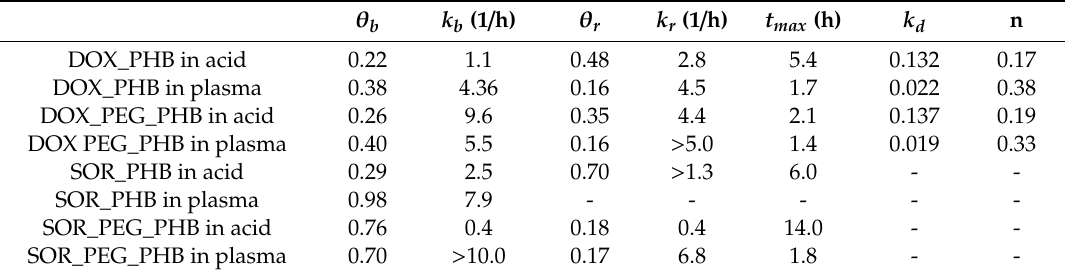
Table 2. Kinetic parameters of the drug release mechanisms, where ’n’ is the diffusion exponent, ’ k b ’ is the initial burst constant, ’ θ b ’ is the contribution of initial burst release over total mass drug release, ’ k r ’ is the rate of the degradation–relaxation constant, ’ k d ’ is the diffusion kinetic constant and ’ t max ’ is the time to achieve a maximum rate of drug release derived from polymer degradation.